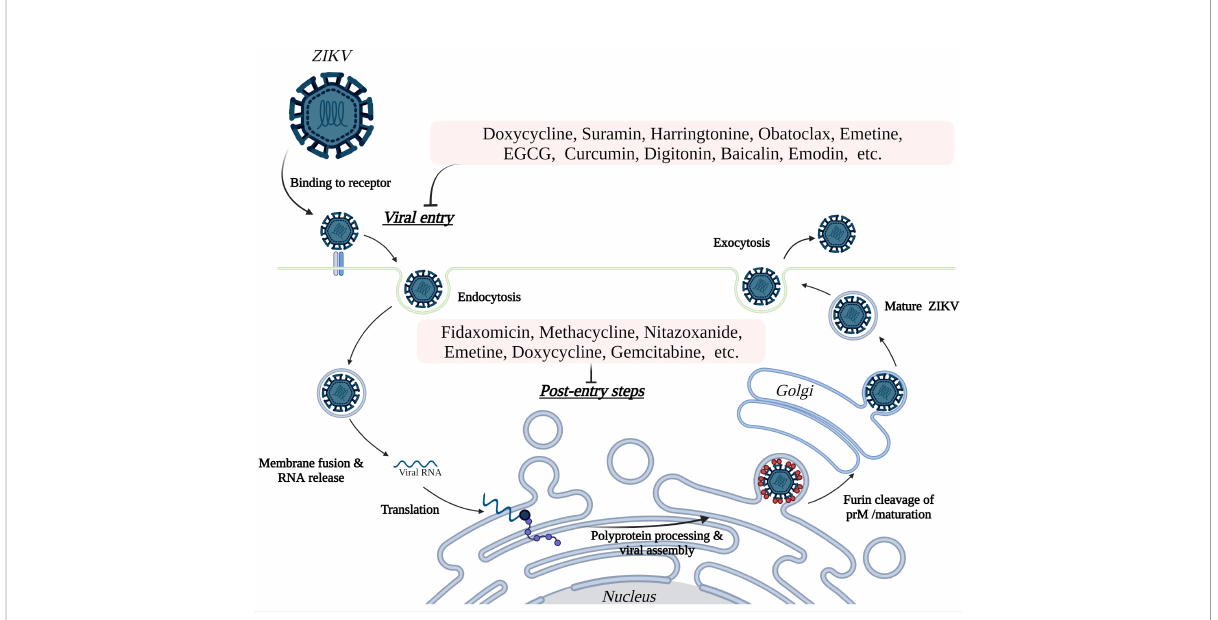
FIGURE 3 Inhibition of ZIKV entry and post entry steps into host cells. ZIKV initiates entry to the host cells by binding to cell surface receptors, including AXL, TYRO3, DC-SIGN, and TIM1. The subsequent endocytosis, fusion, and release of virus particles followed by replication of the RNA genome proceeds in the cytosol and endoplasmic reticulum (ER), respectively. Translation of the genome into a single polyprotein and processing of the polyprotein takes place on the ER membrane. Assembled viral particles bud into the ER lumen as immature viruses and proceed to maturity at the Golgi apparatus, then are released from the cell by exocytosis to perpetuate the cycle of infection. The potential inhibitors of ZIKV (see Table 2 and Supplementary Tables 1, 2) in mammalian cells inhibit the virus replication both at the host cell entry related steps and post-entry